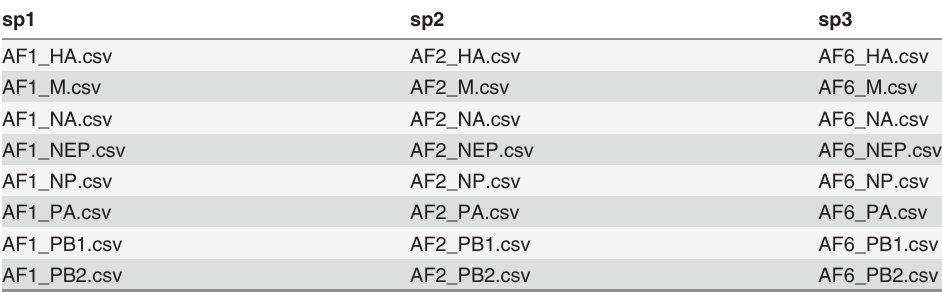
AF1_PB2.csv AF2_PB2.csv AF6_PB2.csv SNPs from eight fragments of sp1, sp 2 and sp3 were compared by SNPer. Each computational SNPs comparison among three viral subpopulations was conducted according to the name of the fi les listed in each row. For instance, for row #1, SNPer compared the SNPs data in fi le “ AF1_HA.csv ” of population